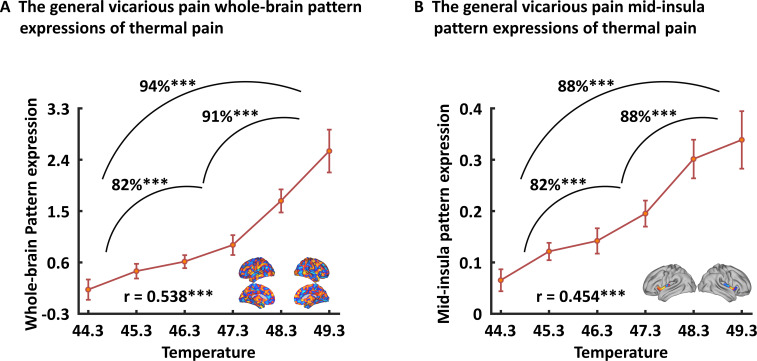
Generalizability of the general (across NS and FE) vicarious pain-predictive pattern.Both whole-brain (A) and mid-insula (B) vicarious pain-predictive patterns could accurately predict the severity and classify the levels of self-experienced pain in an independent dataset. ***p < 0.001. Error bar indicates standard error.